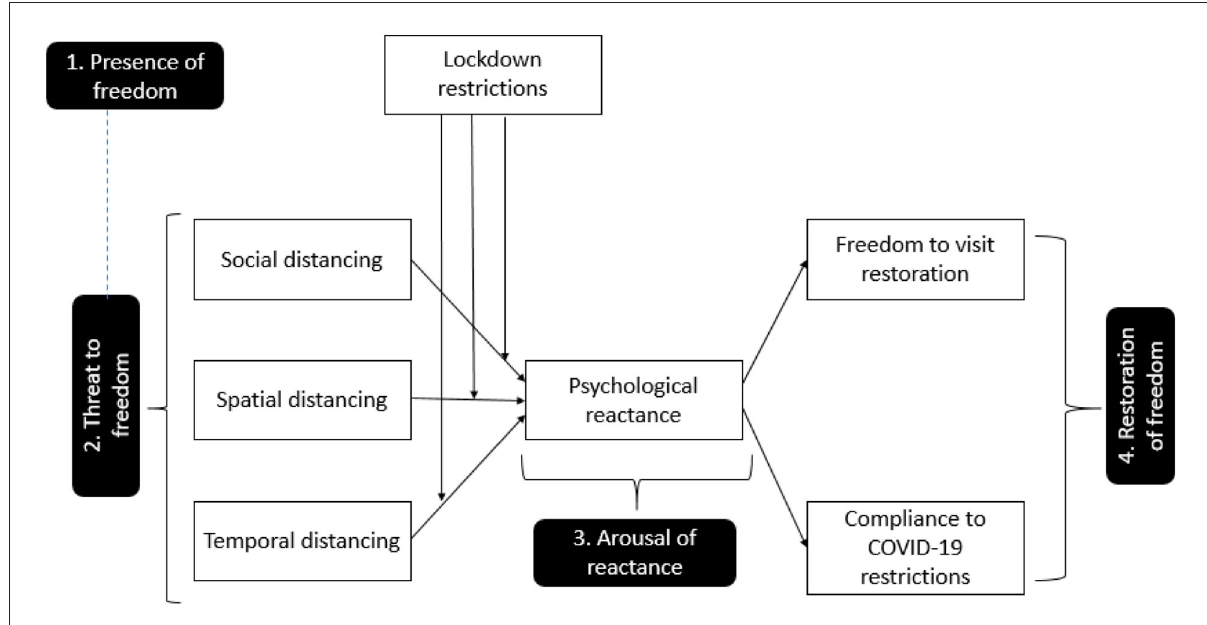
FIGURE1 Psychological reactance